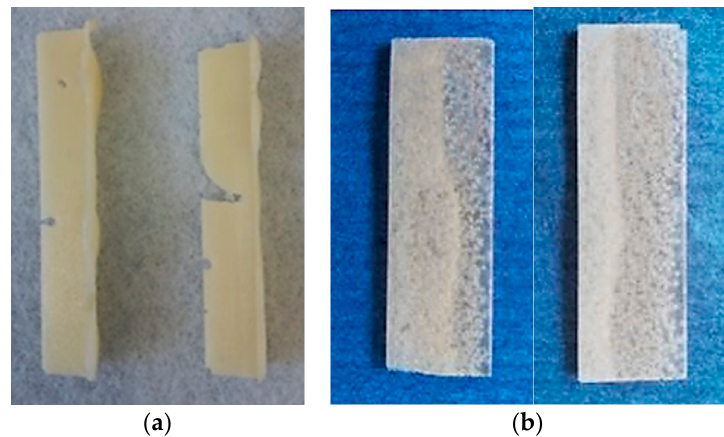
Figure 19. Specimens fabricated using ( a ) method 1, showing defects due to the high volumetric fraction of epoxy matrix and 250 µm PUF-DCPD microcapsules, and ( b ) method 2, presenting microcapsule agglomeration at the surface.